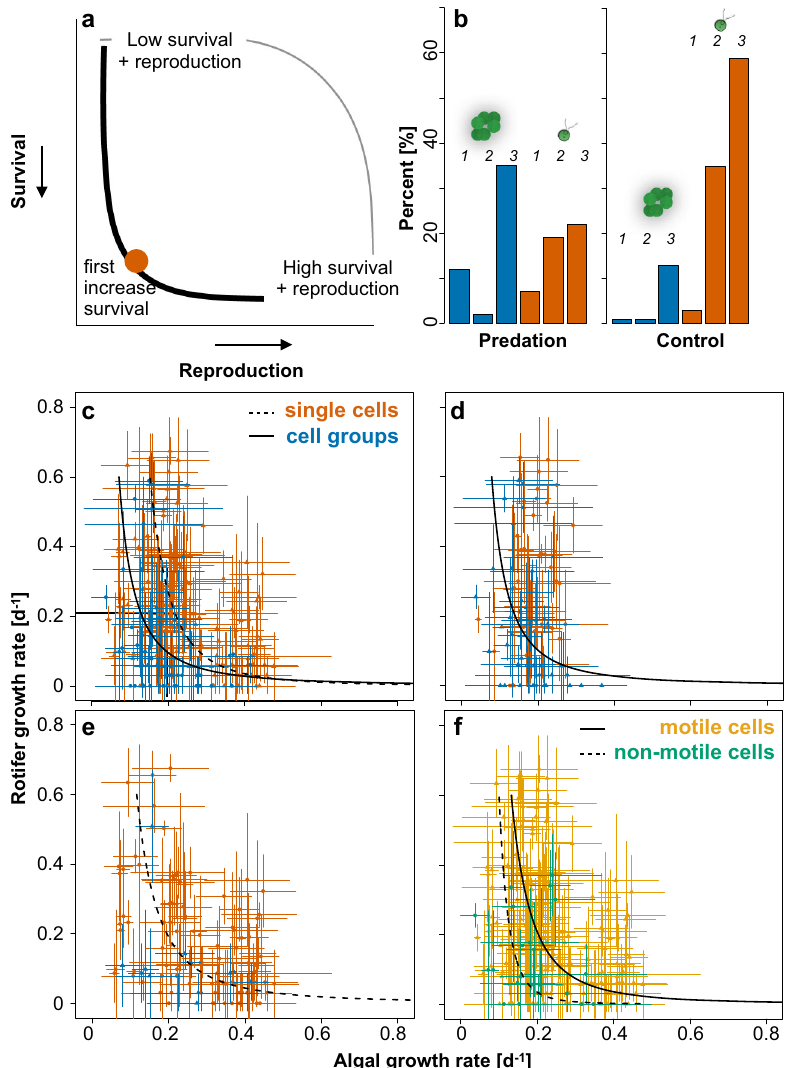
Fig. 1 Selection by predatory rotifers lead to the evolution of cell groups with higher survival but lower growth rate of algae. a Conceptual framework for the evolution of clonal cell groups as a function of the trade-off between reproduction and survival. The convex curvature of the trade-off (increase in survival fi rst) with the orange dot is the one predicted to select fi rst for cell groups followed by the evolution of soma-germ specialization. The concave curve (increase in reproduction fi rst) on the other hand, is predicted to select for fast growing single cells but no further steps towards multicellular life. Modi fi ed from ref. 20 . b Frequency of clone morphologies of isolates classi fi ed into single cells (red) with the subcategories no-motile single cells (1), some motile single cells present (2), majority motile single cells (3), as well as into cell groups (blue) with the subcategories: groups with no single cells (1), groups with non-motile single cells (2) and groups with motile single cells (3). There were signi fi cantly more cell groups selected by predation. c Growth rates of algal isolates and rotifer growth rates when feeding on algal isolates (higher defense of algal isolated for lower rotifer growth rate = higher algal survival). Blue points show data for isolates in cell groups, red triangles for single cells. Black solid line represent predicted trade-off curve for cell groups, black dashed line for single cells (see main text). d Subset of data from c with isolated from the predation-treatment. e Subset of data from c with isolated from the predation-treatment. f The same data as in c but colors indicate motile (yellow) and non-motile single cells/cell groups (green). For c – f shown are means of three replicated measurements per isolate (arrow bars: standard deviation of replicated measurements per isolate) and only signi fi cant trade-off curves. For more details see main text. Source data are provided as a Source Data fi motile: b = − 0.24 ± 0.32; df = 3, F = 7.45, p = 0.013; signi fi cant F = 0.0128, p = 0.9105; Fig. 1d) and only for single cells in the no- levels determined by model comparisons with and without predation lines (cell groups: too few points to fi t model; single exponent, Fig. 1f), but non-motile isolates had a lower growth cells: b = − 0.47 ± 0.12; df = 3, F = 108.07, p < 2.2 * 10 − 16 ; Fig. 1e). Potential costs for Chlamydomonas growing in cell groups rate for similar survival rates. include the potential for self-shading, de fl agellation, loss of motility and/or sedimentation. Indeed, we found a signi fi cant Gene expression patterns . We further tested the heritability of lower frequency of swimming cells across all isolates growing in the evolved phenotypes by comparing the gene expression pat- groups ( χ 2 = 6.85, df = 1, p = 0.009; Fig. 1b). Trade-off curves terns for one-pair single cells from the no predation lines were also more convex for motile and non-motile isolates (majority motile single cells) and evolved cell group from the (motile: b = − 0.39 ± 0.12; df = 3, F = 107.1, p < 2.9 * 10 − 16 ; non- predation line (groups with no single cells) using RNA-seq of the